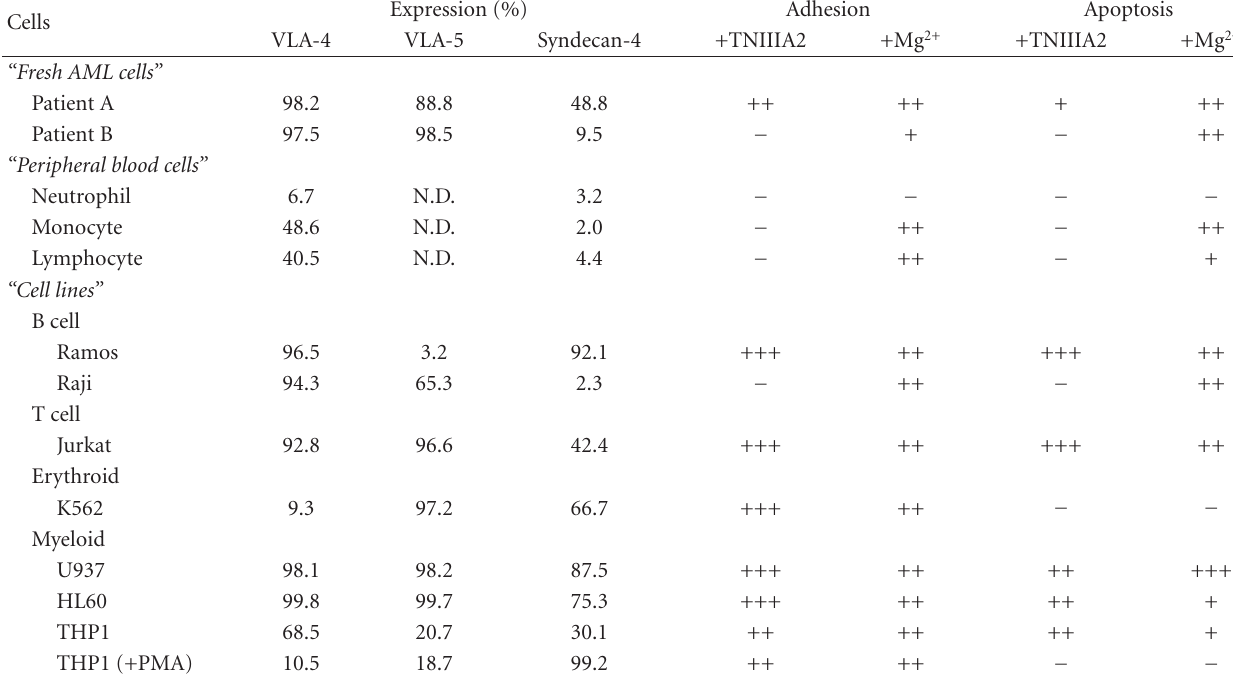
Table 1: Expression level of cell adhesion-relating molecules (VLA-4, 5, and syndecan-4) and induced cell adhesion or apoptosis by TNIIIA2 or Mg 2+ administration in fresh AML cells from patients, peripheral blood cells from healthy adults, and hematopoietic tumor cell lines (the table was modified from